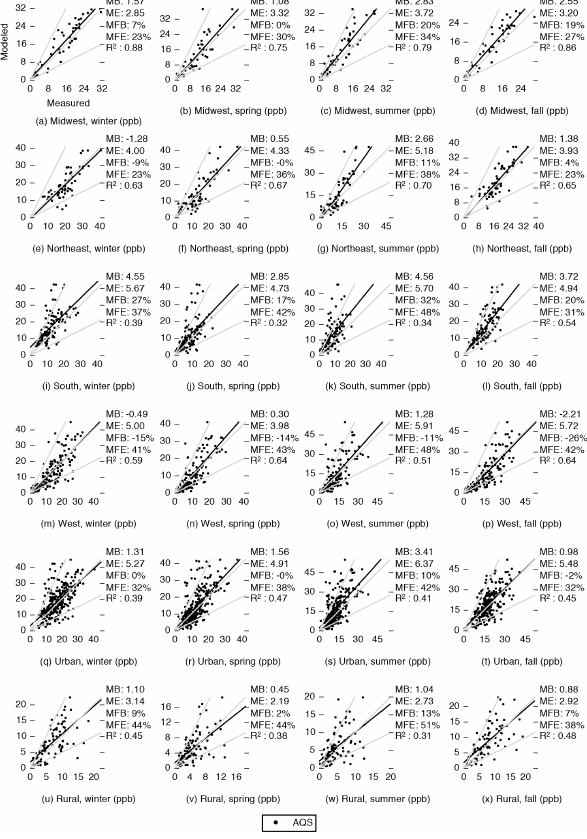
Figure A8. Comparison of modeled and measured SO 2 concentra- tions, disaggregated by region and season.